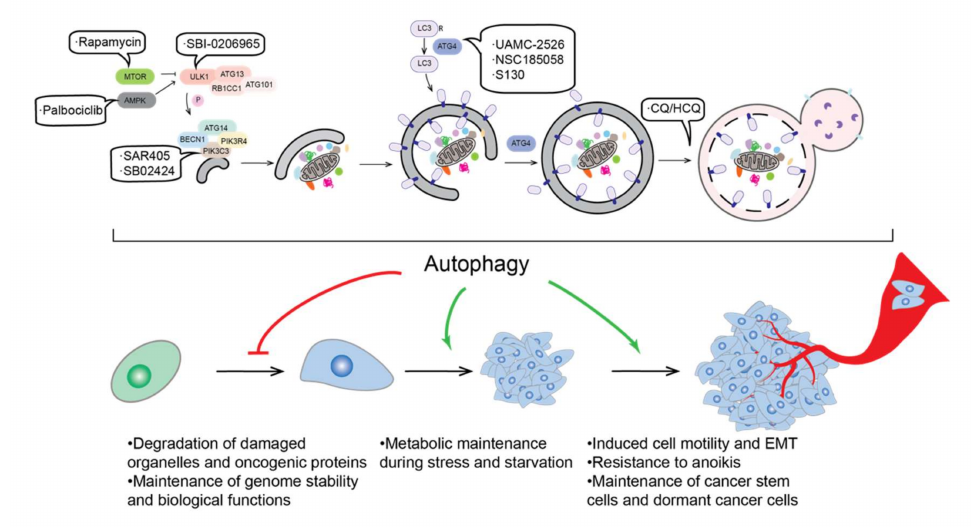
Figure 2. Autophagy in tumor progression and autophagy-targeting cancer therapy. Autophagy has been proposed to inhibit malignant transformation through different mechanisms, including the degradation of damaged organelles and oncogenic proteins and the maintenance of genomic stability and biological functions. After the tumor forms, autophagy basically supports tumor progression mainly through regulating metabolic process during stress or starvation. Tumor-supporting functions of autophagy are also reflected from its ability of promote cell motility, EMT and resistance to anoikis and to maintain cancer stem cells and dormant cancer cells. Because controversial conclusions exist, we only present what most studies indicate. Autophagy modulation could have the ability to treat cancers, and drugs targeting different steps of autophagy have been proposed as potential anticancer therapeutic